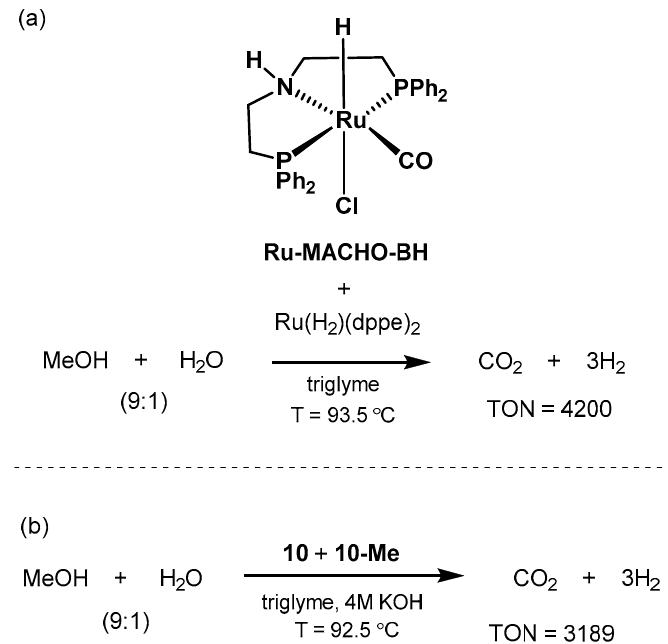
Scheme 13. Beller’s bi-catalytic systems for methanol dehydrogenation catalyzed by